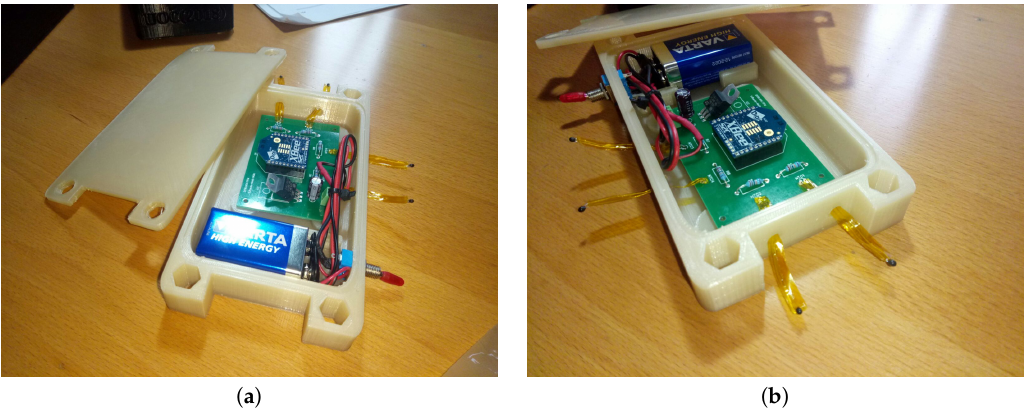
Figure 11. Electronics accommodated inside the waterproof case. ( a ) Battery view. ( b ) Board